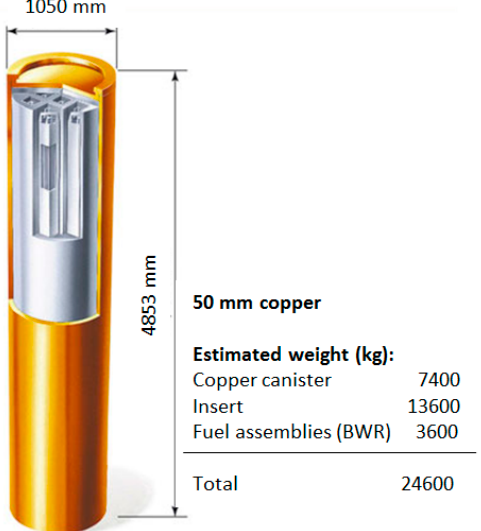
Figure 1. Copper canisters assembly with carbon steel containers for spent nuclear